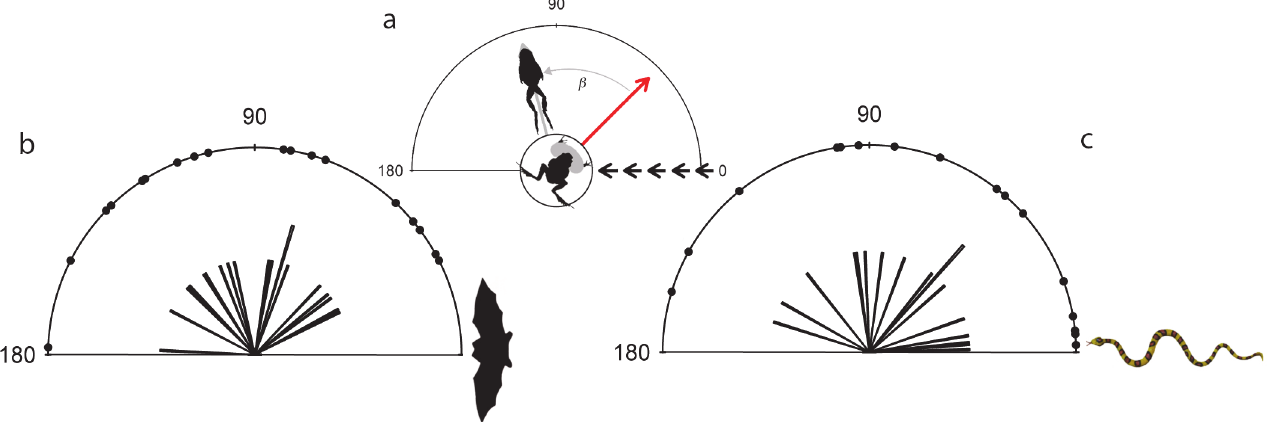
Fig 3. The extent the túngara frogs rotated to reach their resultant escape angles. (a) Schematic illustrates the method for calculating how far the frog rotated when fleeing; β indicates the angle moved by the frog relative to its initial position. There was no significant difference in fleeing angle between frogs presented with bat (b) and snake (c)